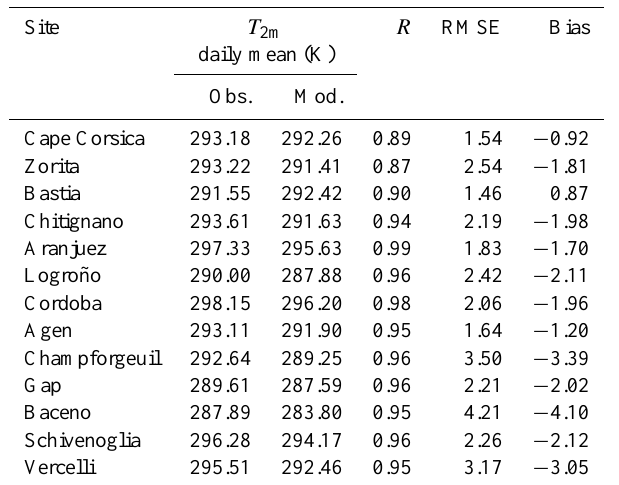
Table 5. Hit rate (HR) and bias of measured and modeled daily mean averaged values of precipitation amount (mmday − 1 ). The bias expressed the (model) minus (observations) values. Site N obs Pr (mmday − 1 ) HR Bias Obs.